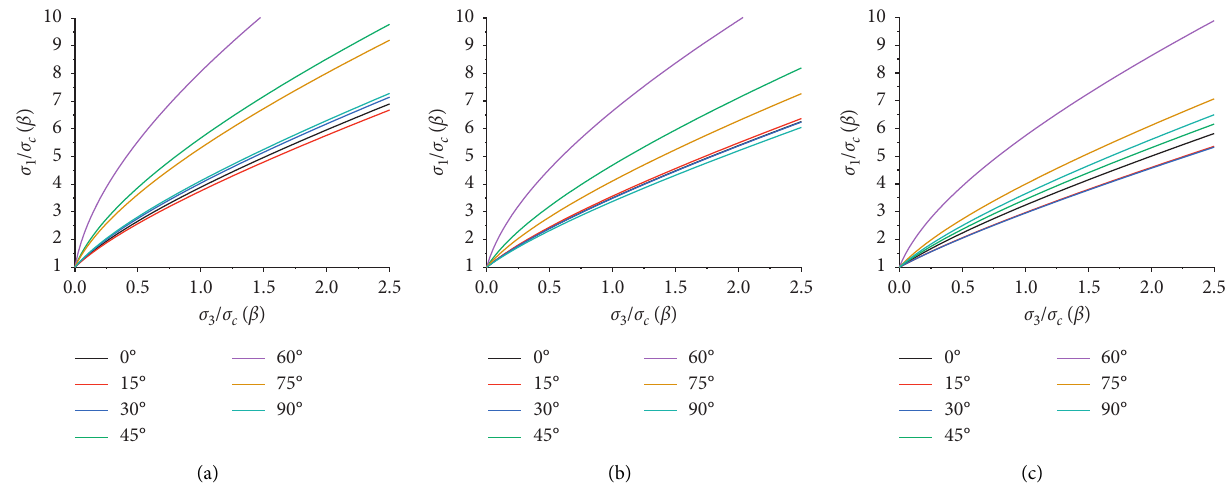
Figure 15: Dimensionless standardized Hoek–Brown strength curve. (a) Group AA, (b) Group AB, and (c) Group